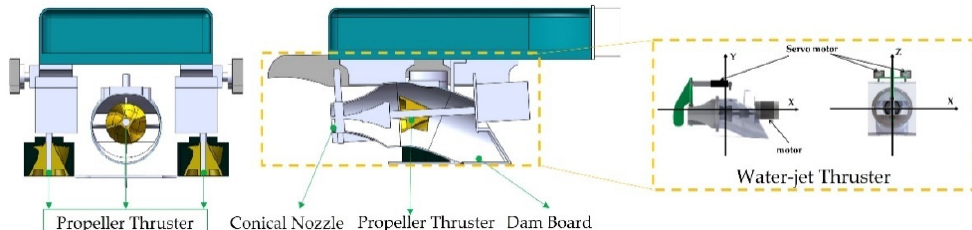
Figure 10. The cutaway view of the son underwater robot.